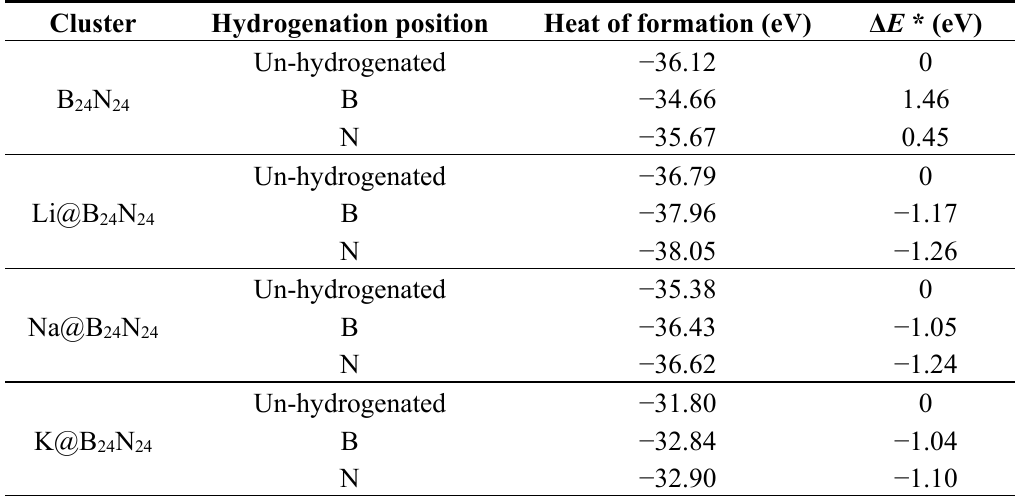
Table 5. Chemisorption energies of a hydrogen atom on M@B 24 N 24